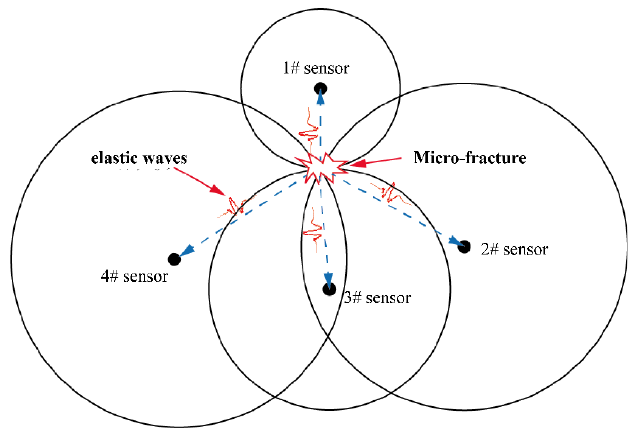
Figure 2. Schematic of MS monitoring.